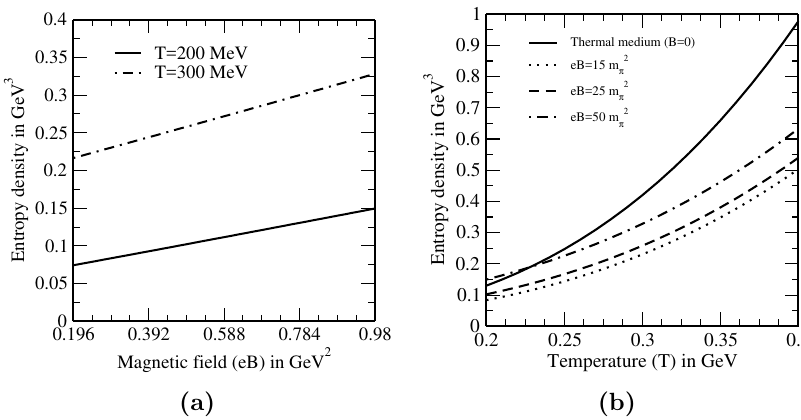
Figure 5 . The variation of entropy density as a function of magnetic (cid:12)eld at di(cid:11)erent temperatures (a) and as a function of temperature at di(cid:11)erent strong magnetic (cid:12)elds (b).